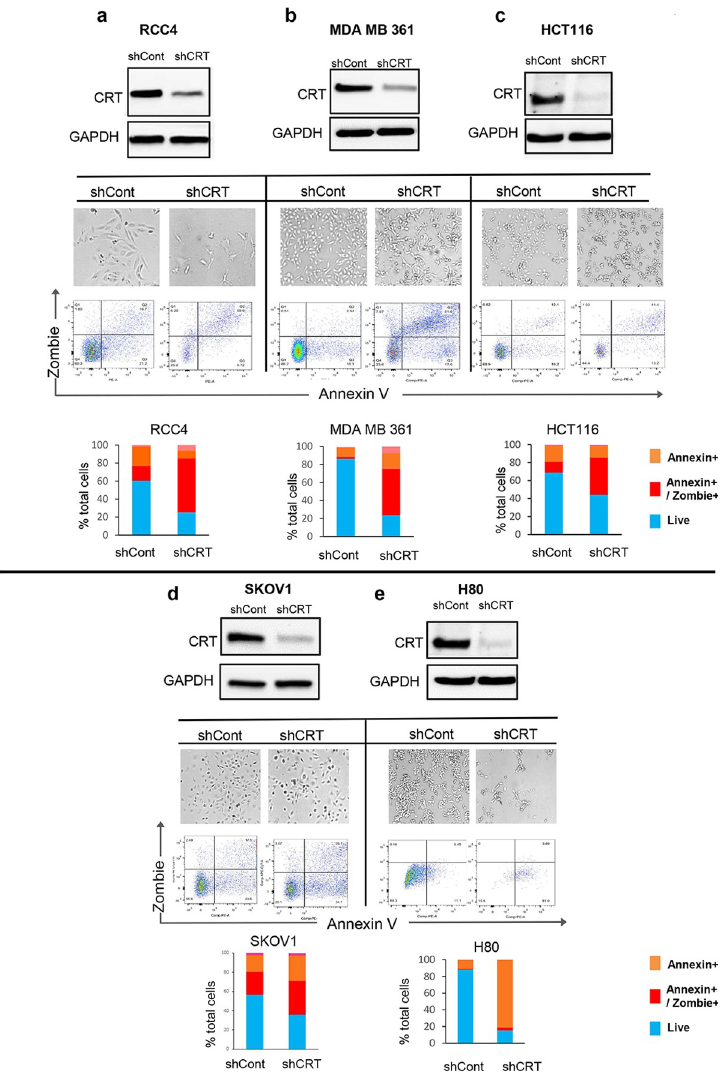
Fig 2. Inhibition of CRT expression initiates the death response in the cells derived from solid-tissue malignancies. Down-regulation of CRT protein (as confirmed by WB) in the cells originating from kidney (A), breast (B), colon (C), ovary (D), and neuronal (E) malignancies causes drastic morphological changes (light microscope at 20 × magnification representative images are shown) and a significant increase in the Zombie/Annexin positive cells, all indicative of the active process of cell death. Underlying source data can be found in S1 Data. Bar graphs show percentage of live or dead cells in an indicated tumor types. CRT, calreticulin; GAPDH, Glyceraldehyde 3-phosphate dehydrogenase; HCT116, Human colorectal carcinoma cell line; MB, megabase; MDAMB361, human breast adenocarcinoma cell line; RCC4, Human clear cell renal cell carcinoma cell line; shCont, short hairpin RNA targeting Control; shCRT, short hairpin RNA targeting Calreticulin; SKOV1, Human ovarian carcinoma cell line; WB, Western blot.